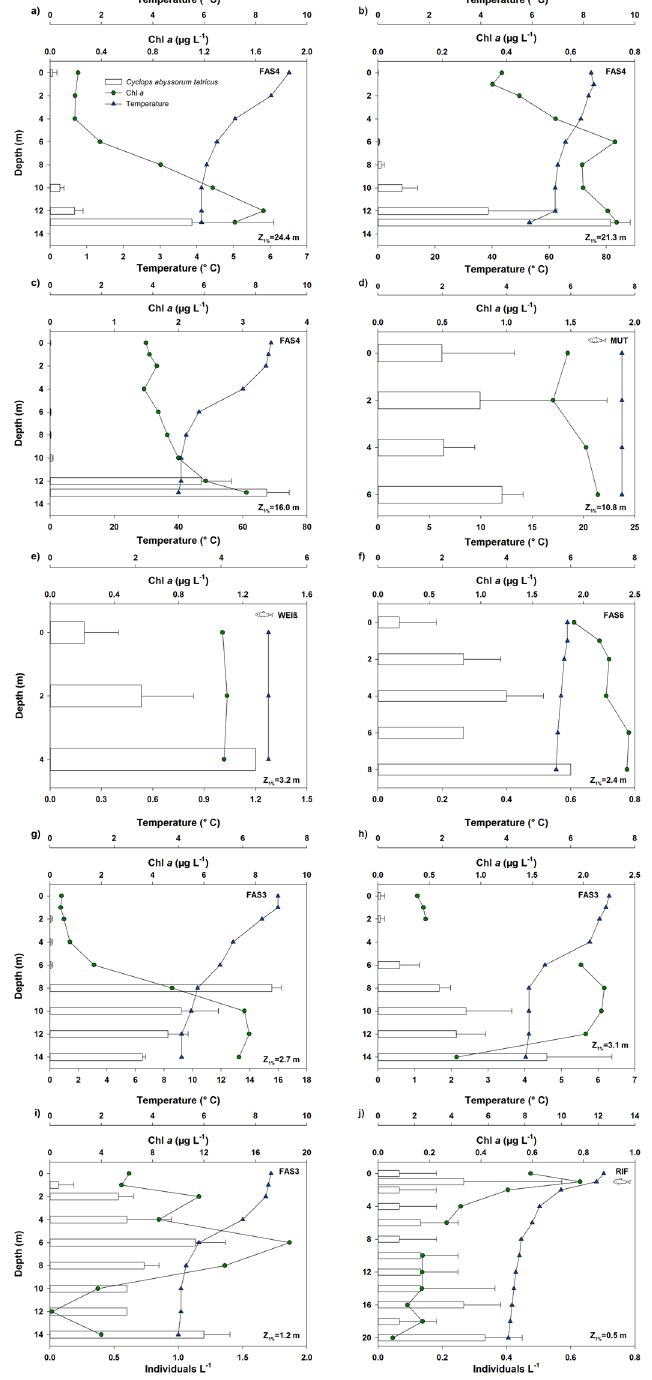
Figure 1. Vertical daytime distribution of Cyclops abyssorum tatricus , Chlorophyll a (Chl a ), and temperature in six alpine lakes during the ice-free period of 2010 and 2011. The lakes are ordered from clear (i.e. no glacier connectivity, NTU < 1) to turbid (i.e. glacial influence, NTU > 1). Error bars indicate + 1 standard deviation. Bars without error bars indicate a standard deviation of zero. ( a ) FAS4 July 2010, ( b ) FAS4 July 2011, ( c ) FAS4 August 2011, ( d ) MUT, ( e ) WEIß, ( f ) FAS6, ( g ) FAS3 July 2010, ( h ) FAS3 July 2011, ( i ) FAS3 August 2011, ( j ) RIF (abbreviations for the lakes are defined in Table 1). Z 1% = 1% of the surface irradiance at 320